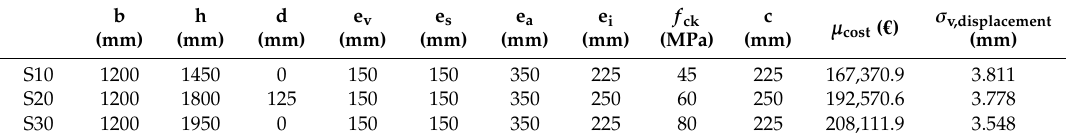
Table 4. Comparison of design with the same structural behavior in modulus of elasticity RDO Table4. Comparisonof designwith thesame structuralbehavior inmodulus ofelasticityRDO problems. problems.